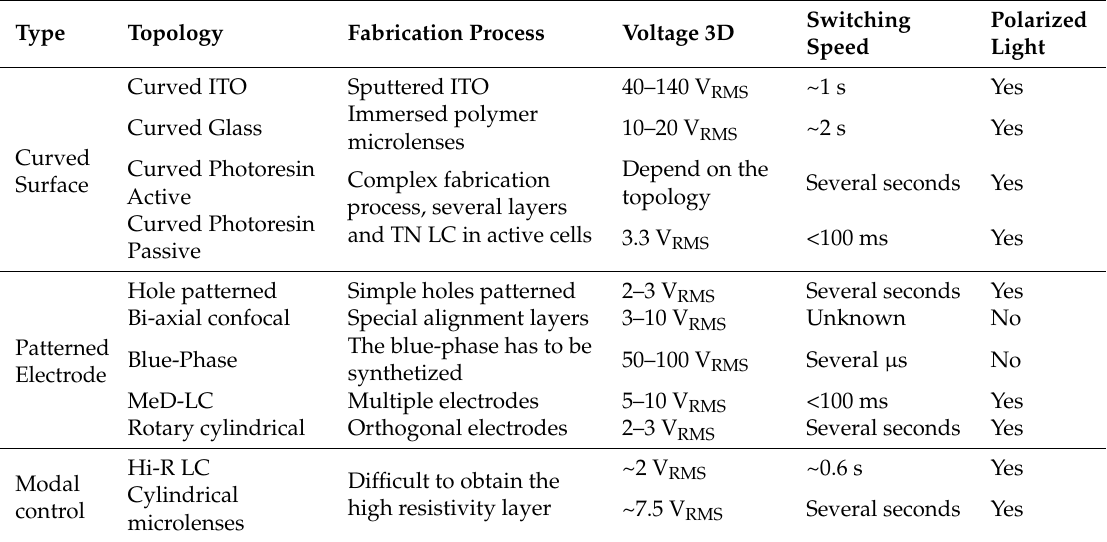
Table 3. Comparison between different LC microlenses